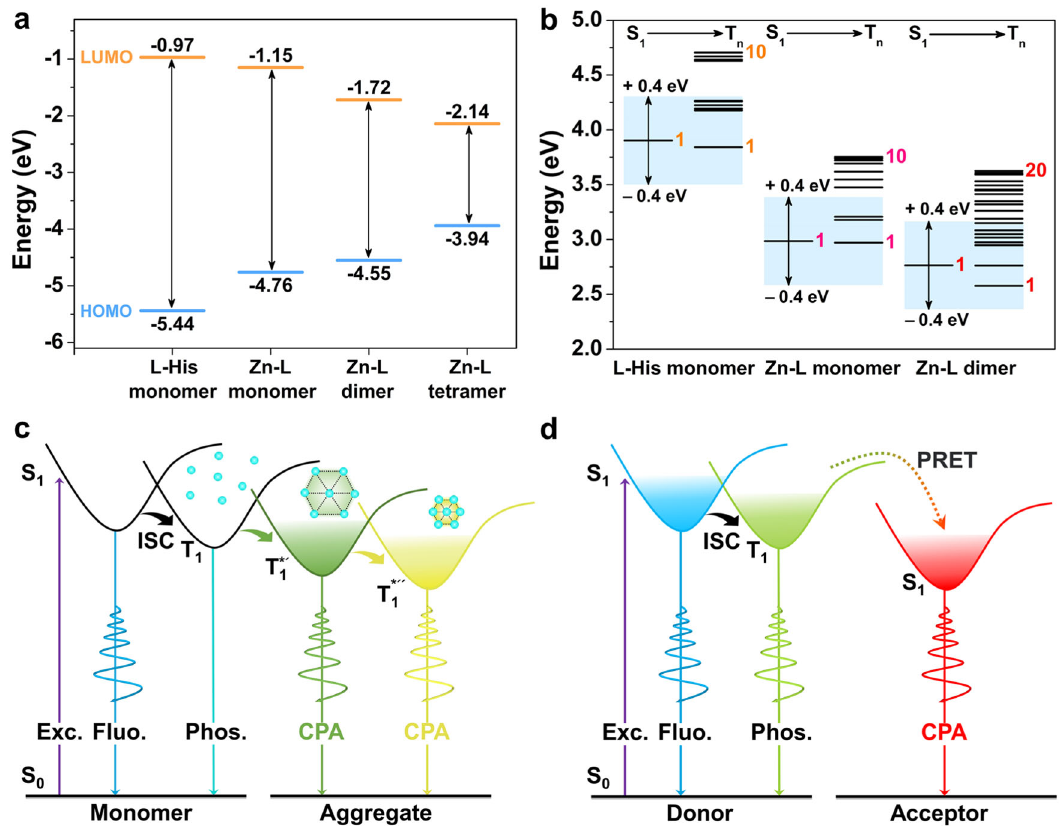
Fig.6 |Theoreticalanalysesofcolor-tunableCPAfrom SGs.a Calculated energy bandgaps for the selected L-His monomer extracted from the L-His single crystal (CCDC: 1206542), and Zn – L monomer and aggregates extracted from Zn – L single crystal.TheblueandorangelinesillustratetheenergyvaluesofHOMOandLUMO, respectively. b TD-DFT calculated energy level diagrams of selected L-His mono- mer, as well as Zn – L monomer and dimer in L-His and Zn – L single crystal, respectively. c , d Proposed mechanisms of the CPA emissions from Zn – L SGs and RB doped SGs. Cyan ball represents the Zn – L complex. The black dotted line symbolizes non-covalent interaction between the complexes — the shorter the line,